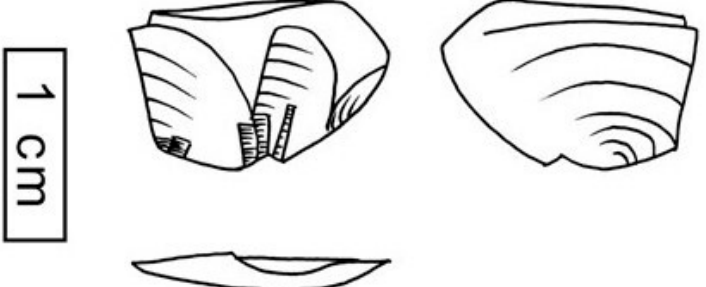
Figure 19. Flake d1+ illustrating the characteristics of a vertical sequential reduction flake (drawing by the author). The flakes removed in this reduction sequence are all in the same